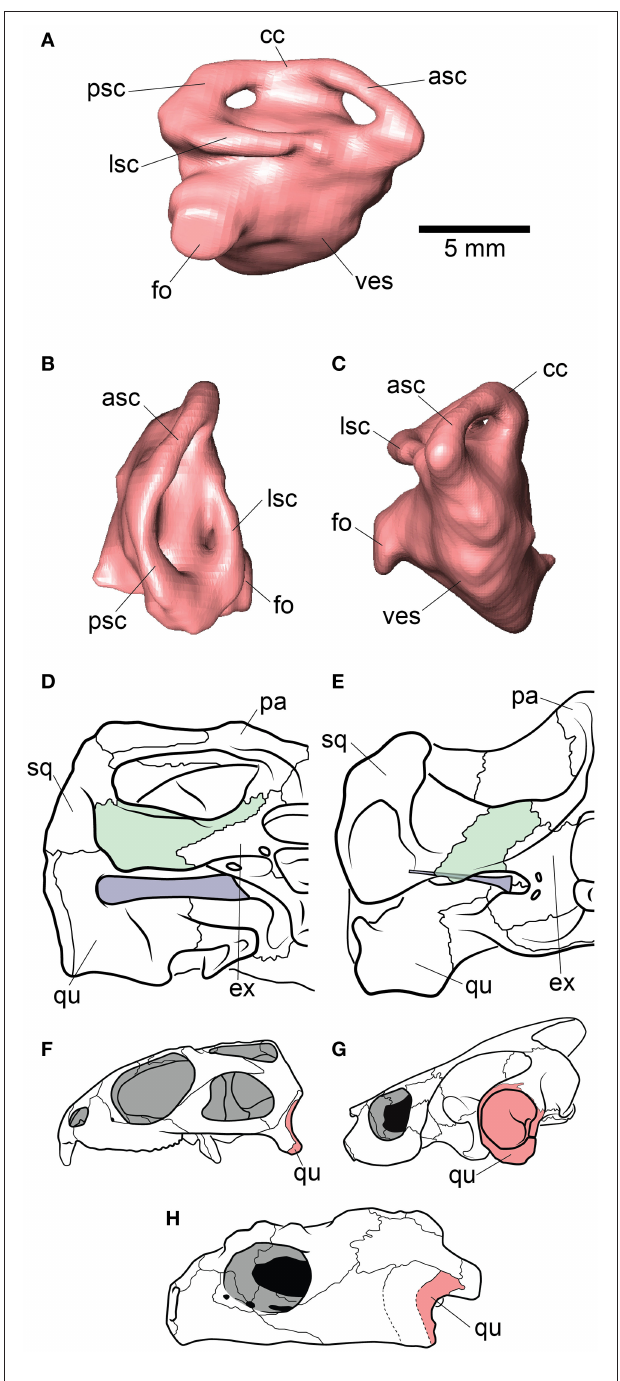
FIGURE 4 | Inner ear and otic region anatomy of Proganochelys quenstedti . Digital reconstruction of the right endosseus labyrinth of P. quenstedti in (A) right lateral, (B) dorsal, and (C) anterior views. Skulls of (D) P. quenstedti and (E) Eubaena cephalica in posterior view, redrawn from Gaffney (1990) with opisthotic and stapes colored in green and blue, respectively. Skulls of (F) Sphenodon punctatus , (G) Emydura macquarii , and (H) P. quenstedti in lateral view, redrawn from Ferreira and Werneburg (in press), with quadrate colored in red. Note the larger proportions of the stapes and its contact with the quadrate bone in P. quenstedti , and its slender and tall quadrate, similar to that (Continued)